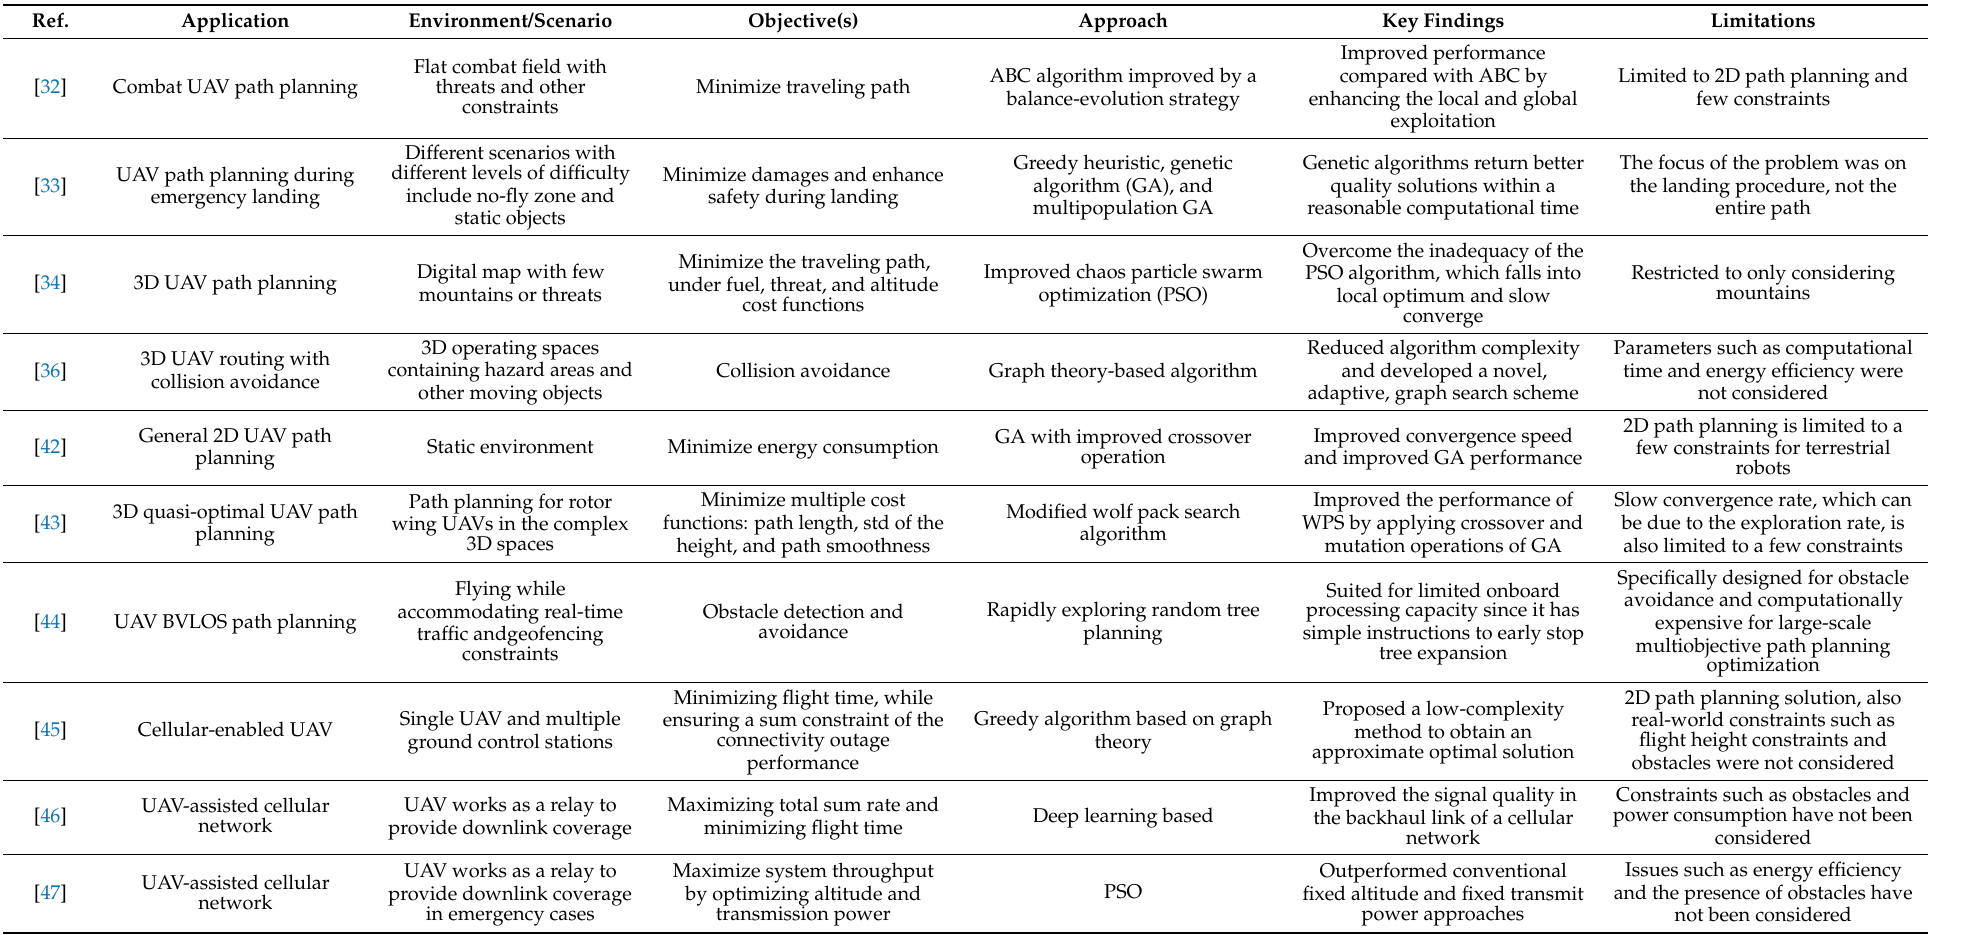
Table 1. A summary of the reviewed UAV path planning